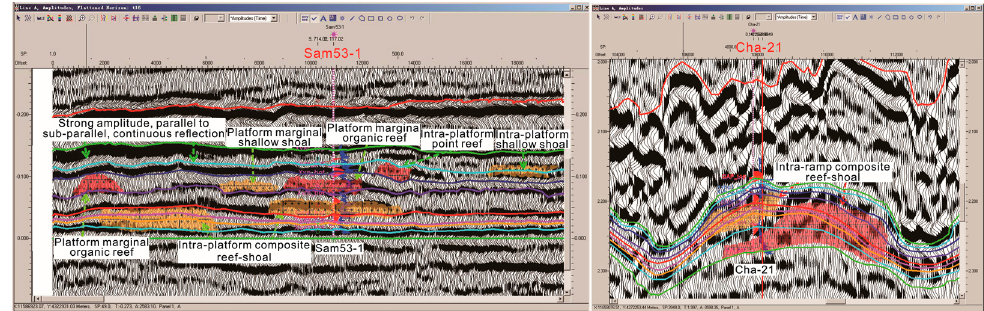
Figure 7. Interpretation of facies types based on seismic profiles in Samendepe and Chashgui areas, well sites are in Figure 3 (Reference [37]).